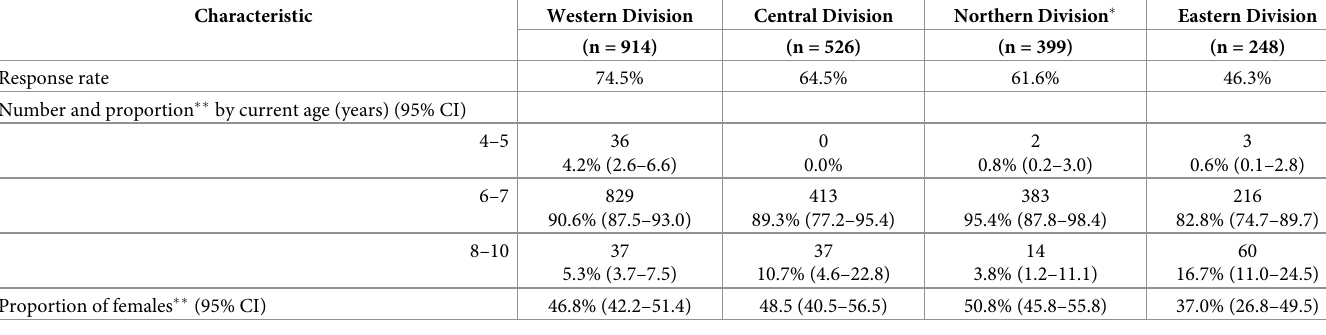
Table 2. Demographic characteristics of class 1 and 2 students in the 4 Divisions of Fiji, 2014–2015.